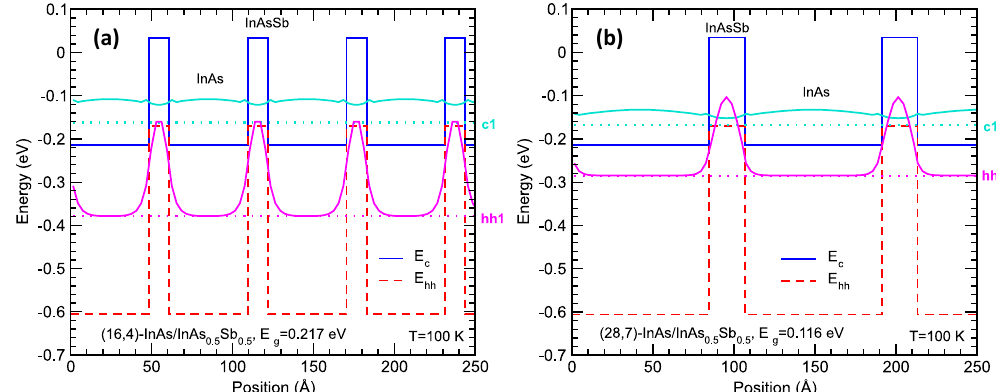
Figure 3. Energy band diagrams showing the bulk InAs and InAsSb conduction band edge ( E c) and valence band edge ( E hh ), the superlattice zone-center c1 and hh1 energy levels (dotted lines), and the corresponding c1 and hh1 state probability densities (solid lines) for ( a ) the (16,4)-InAs / InAs 0.5 Sb 0.5 strained-layer superlattice (SLS), and ( b ) the (28,7)-InAs / InAs 0.5 Sb 0.5 SLS at 100 K. The InAs and InAsSb layers are, respectively, under tensile and compressive strain on the GaSb substrate.